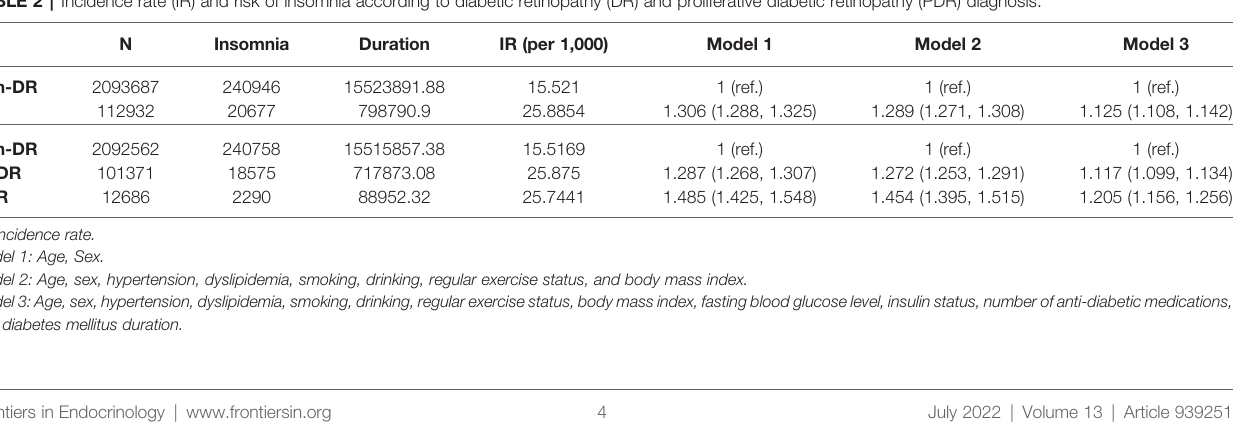
TABLE 2 | Incidence rate (IR) and risk of insomnia according to diabetic retinopathy (DR) and proliferative diabetic retinopathy (PDR) diagnosis.